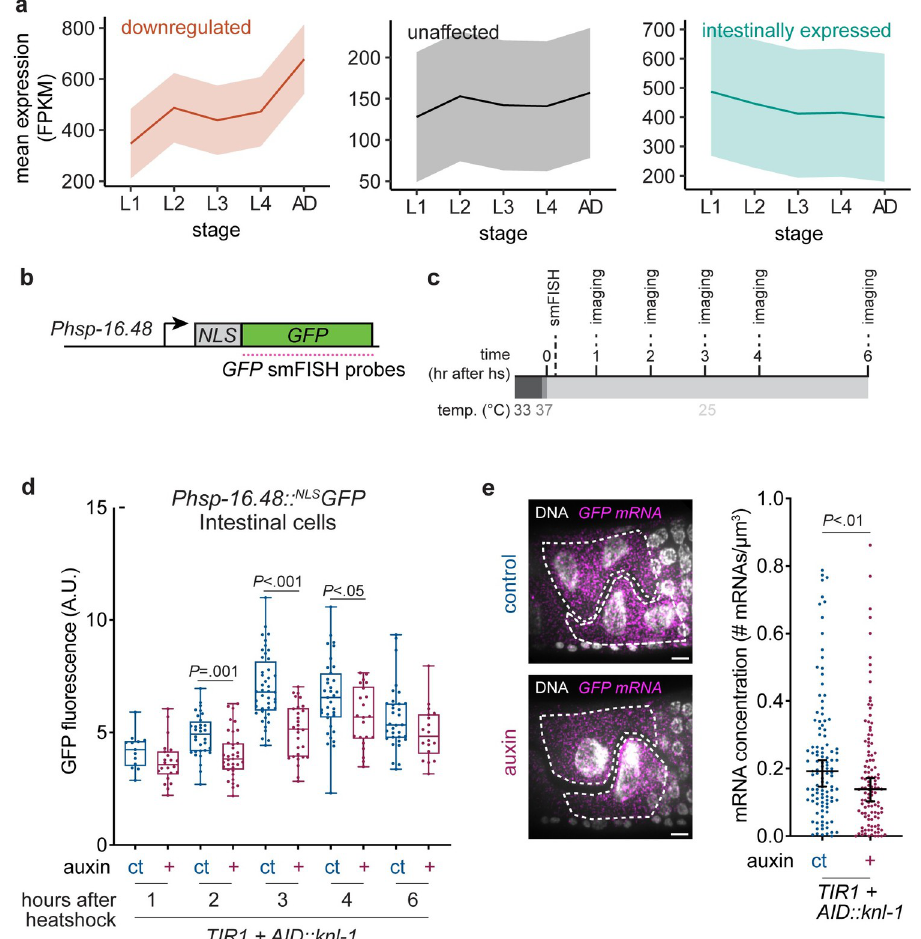
Fig 6. Binucleation allows rapid up-regulation of transcription. (A) Mean expression for down-regulated ( n = 96 genes), unaffected ( n = 113 genes), or intestinally expressed ( n = 80 genes) subsets of genes in different developmental stages from ModEncode FPKM gene expression data. Area around curve shows confidence interval. (B) Schematic overview of heat shock–inducible NLS-GFP transgene. smFISH probes were designed against the sfGFP sequence. (C) Schematic overview of smFISH and imaging experiments following heat shock induction in Pges-1 :: TIR1; AID :: knl-1 animals. Young L4 stage animals grown under control or auxin conditions were heat shocked in a water bath at 33˚C for 30 minutes, followed by 5 minutes in a 37˚C air incubator. Animals were left to recover at 25˚C. Samples were taken after 15 minutes for smFISH analyses or every hour, for the analysis of nuclear GFP accumulation. (D) Total nuclear fluorescence intensities of intestinal nuclei at different time points after heat shock for animals grown under control (ct, n = 13 to 44) or auxin (+, n = 18 to 35) conditions, in 3 replicate experiments. Boxplots indicate the median and 25th to 75th percentile, error bars indicate min to max values, and individual values are shown as dots. P values were calculated by Student t test. (E) Representative smFISH images and quantifications of cellular GFP mRNA concentration in animals grown under auxin (+, n = 113) or control (ct, n = 112) conditions 15 minutes after heat shock, in 2 replicate experiments. Scatter plot with median (middle line) and 95% confidence interval (error bars). Each dot represents mRNA concentration in a single cell. P value was calculated by Mann–Whitney test. Scale bar represents 5 μ m. Underlying data can be found in S1 Data. AID, auxin-inducible degron; FPKM, fragments per kilobase of exon per million mapped fragments; smFISH, single molecule fluorescence in situ